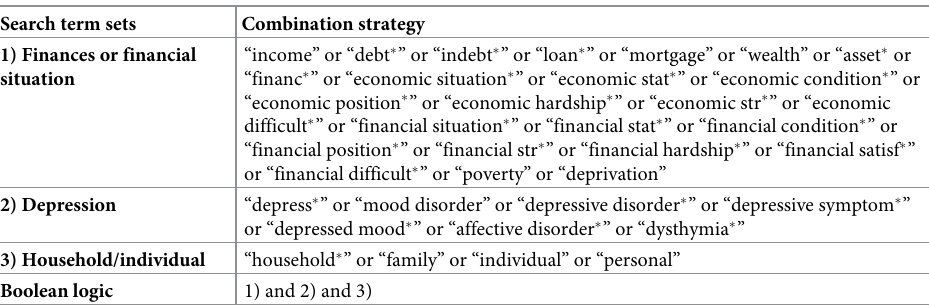
Table 1. A simplified search